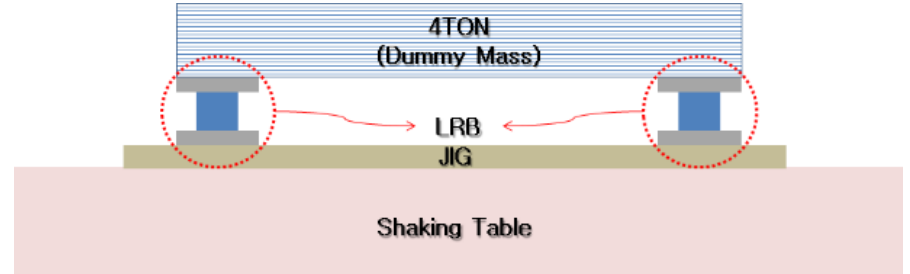
Figure 9. Schematics of 3D shaking table test.